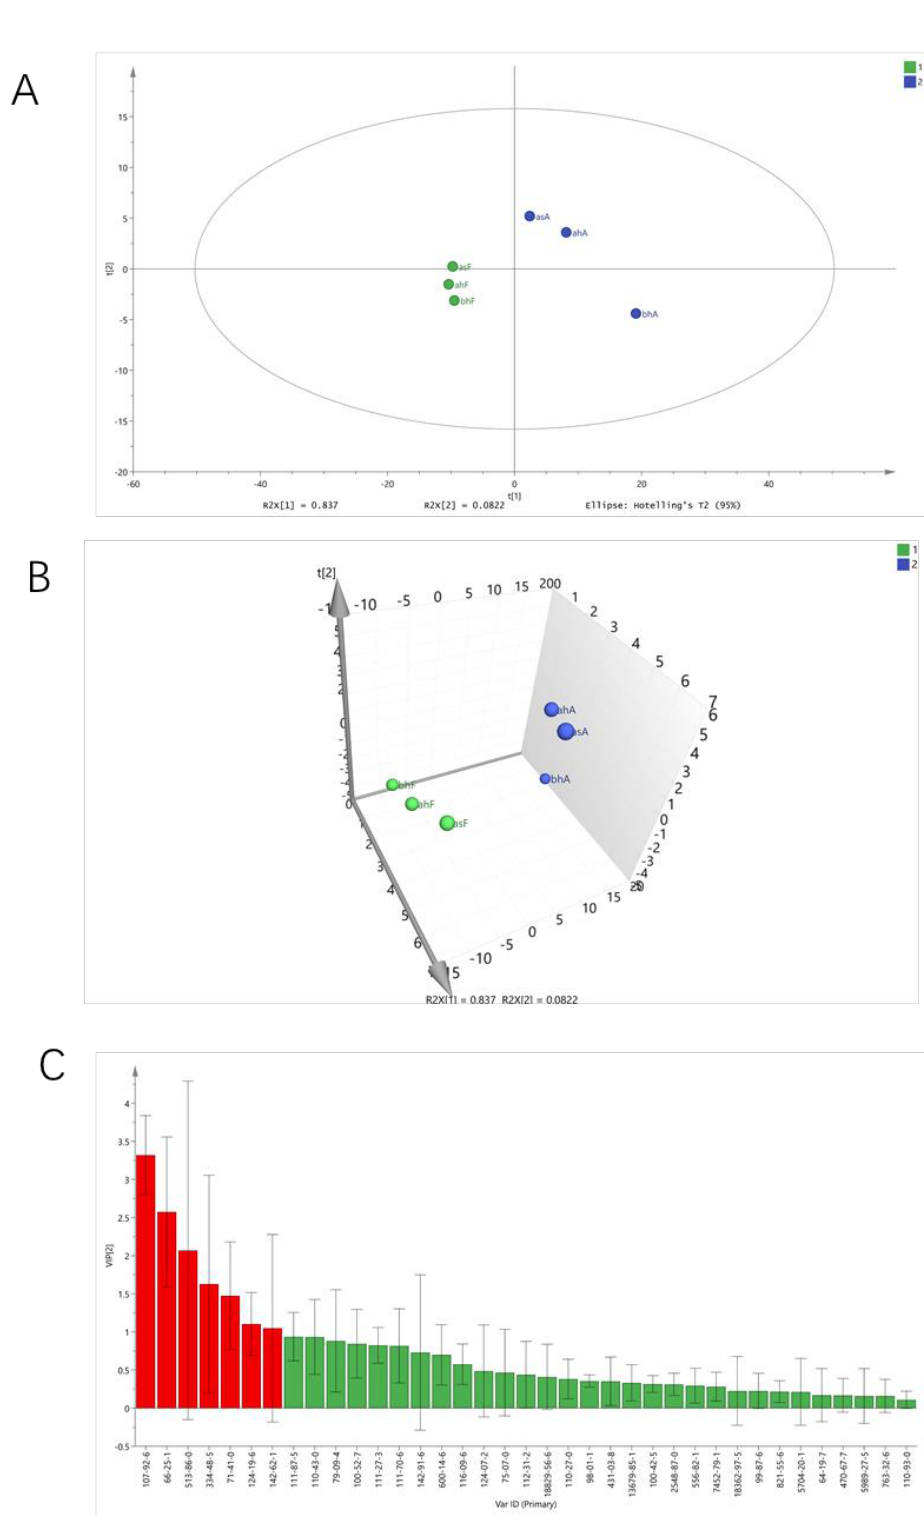
Figure 4. 2D (A) and 3D (B) score charts of PLS-DA and VIP diagram (C; red means VIP > 1, Figure 4. 2D ( A ) and 3D ( B ) score charts of PLS-DA and VIP diagram ( C ; red means VIP > 1, green green means VIP < 1 ) of the six samples (R 2 X = 0.919, R 2 Y = 0.98, and Q 2 = 0.88). means VIP < 1) of the six samples (R 2 X = 0.919, R 2 Y = 0.98, and Q 2 =